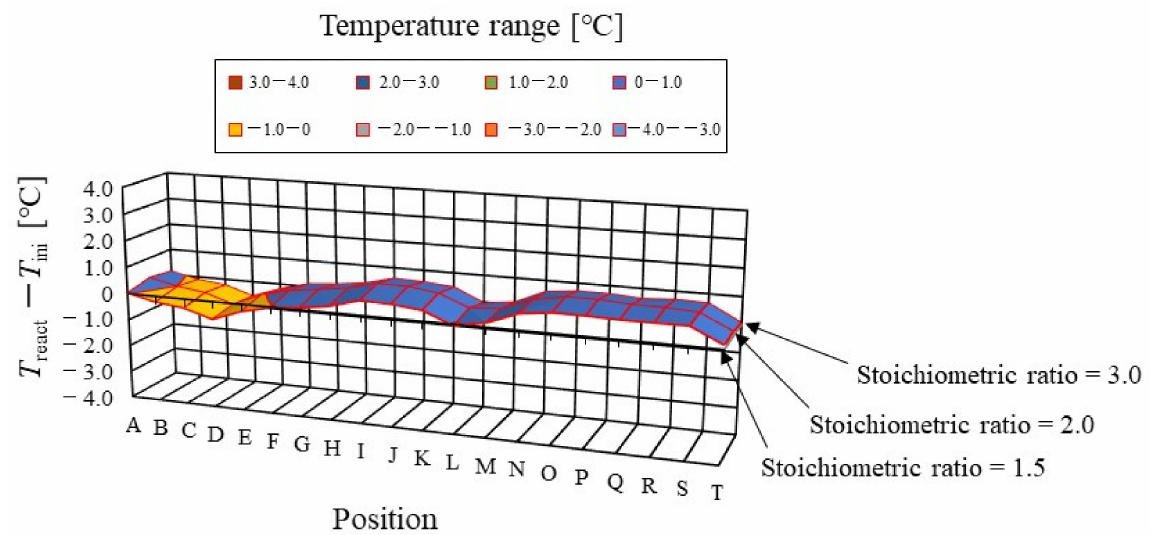
Figure 6. Color counter to clarify the effect of stoichiometric ratio of supply gas on distribution of temperature difference, between temperature at reaction surface and initial operation temperature, at the initial operation temperature = 80 ◦ C and A 80% RH and C 80% RH,